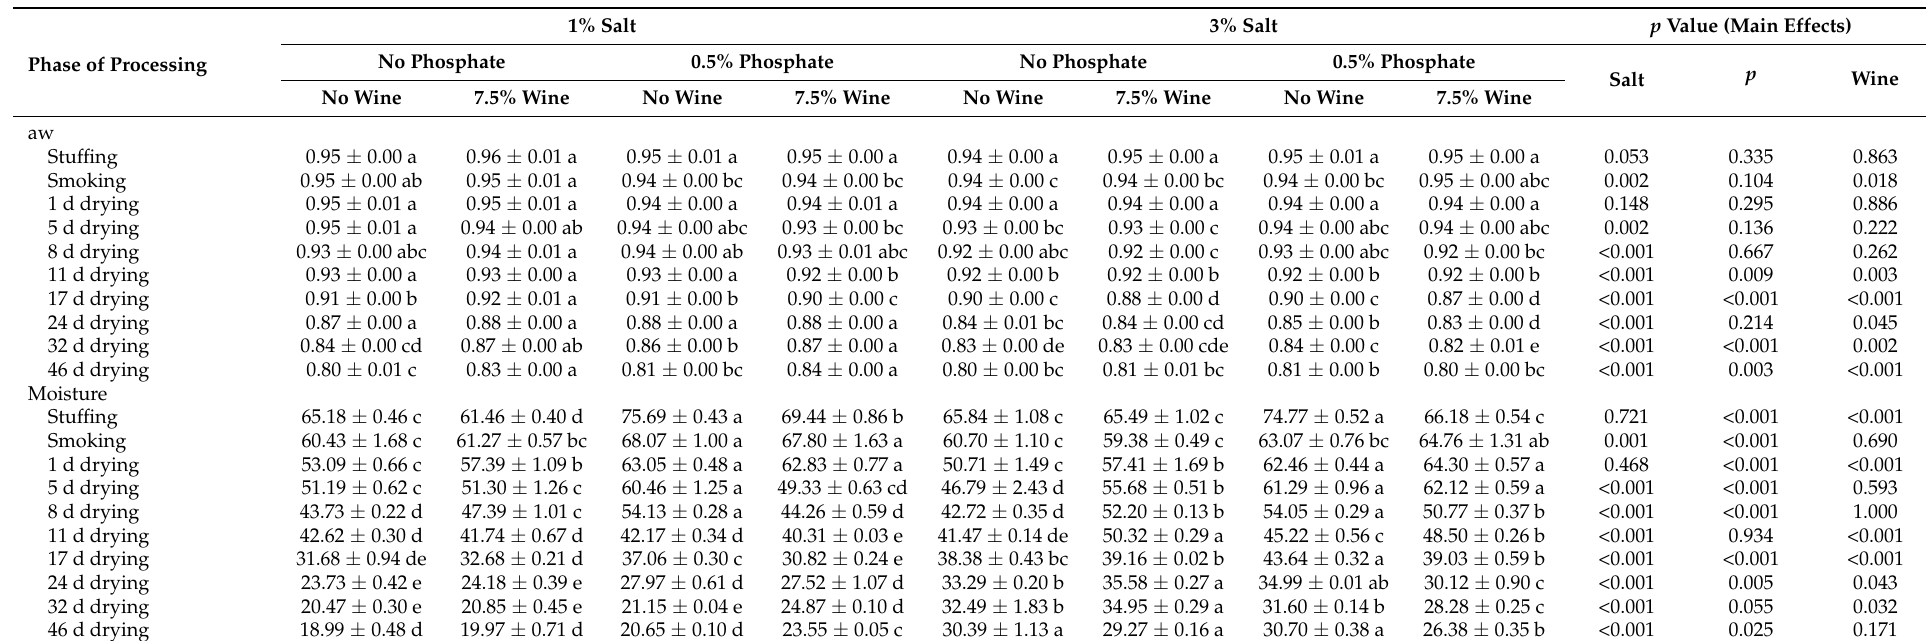
Table 2. Water activity (aw) and moisture in cured sausage with different formulations during processing. Results expressed as mean ± standard deviation. ( p =